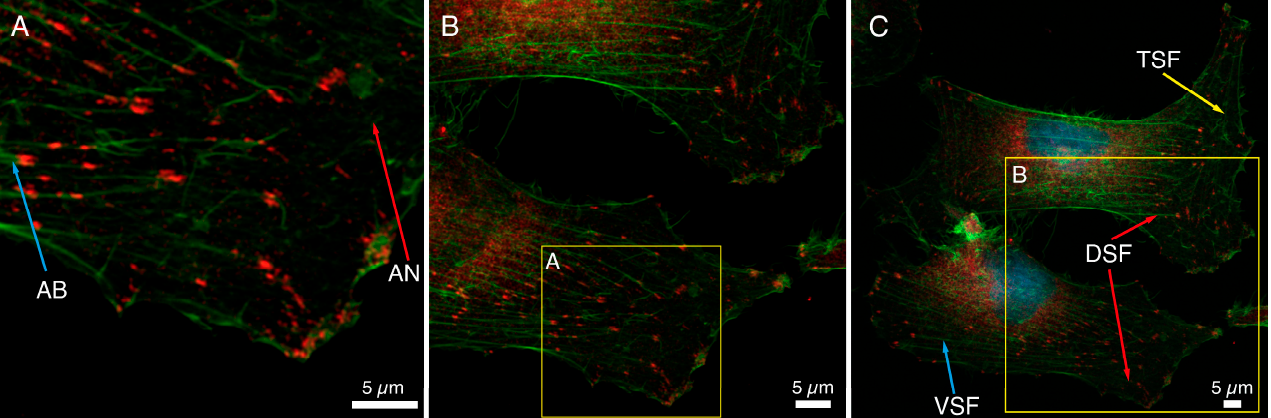
Figure 1. Analysis of the size and distribution of focal adhesion in HCC38 cells with immunostaining. ( A – C ) The focal adhesions in the cells were shown using anti-paxillin antibodies conjugated to Alexa Fluor 647 (red). The actin in the cytoskeleton was stained with phalloidin conjugated to Alexa Fluor 488 (green). Images under CLSM using Plan- Apochromat 63× objective at different scan area. Scale bar represents 5 μ m.